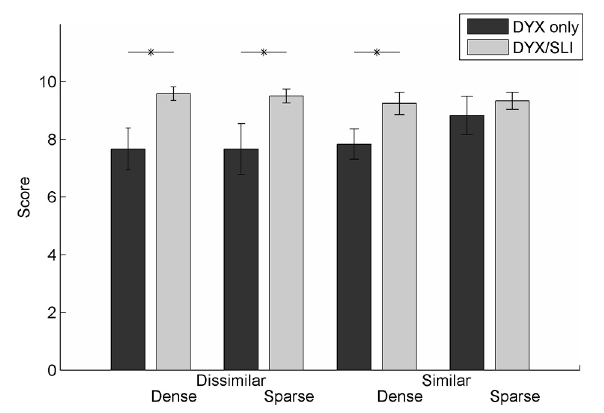
FIGURE 4 | Comparison of performance on the repetition portion of the task between DYX only and DYX/SLI children. Children with dyslexia alone (DYX) displayed a different pattern of accuracy compared to children with dyslexia that were also comorbid for SLI (DYX). Children with DYX only has significantly lower accuracy on three of the four stimulus types (unpaired t -tests, dissimilar/dense, p < 0 . 01; dissimilar/sparse, p = 0 . 01; similar/dense, p = 0 . 03; similar/sparse, p = 0 .